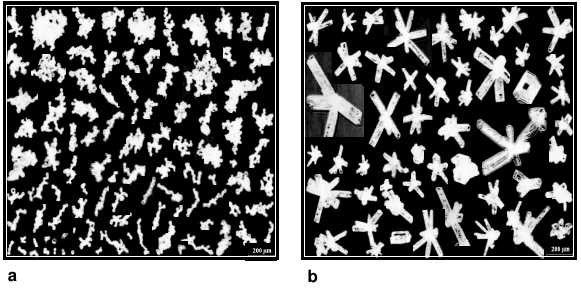
Fig. 8. Examples of ice crystal images measured by the CPI in- strument. (a) : Chain-like aggregates observed near the top of the overshooting cell (11080m/ − 58 ◦ C). (b) : Bullet-Rosettes sampled near − 45 ◦ C in the cirrus.